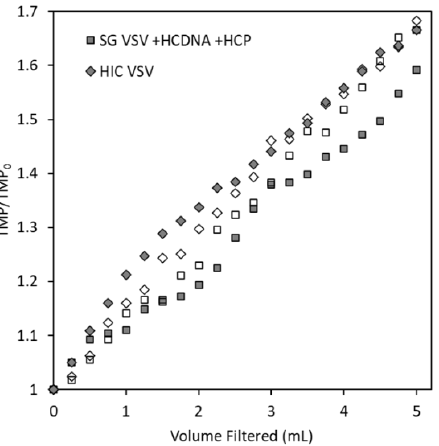
Figure 3. Transmembrane pressure (TMP) profiles (reported as the ratio of the measured TMP to the initial TMP) for the constant flux filtration (0.3 mL min −1 cm −2 ) of two vesicular stomatitis virus (VSV) solutions (identified by the symbol shape) through the Durapore PVDF 0.22 µm microfiltration membrane. The empty and filled symbols for each shape represent the duplicate filtration tests that were conducted for each solution.